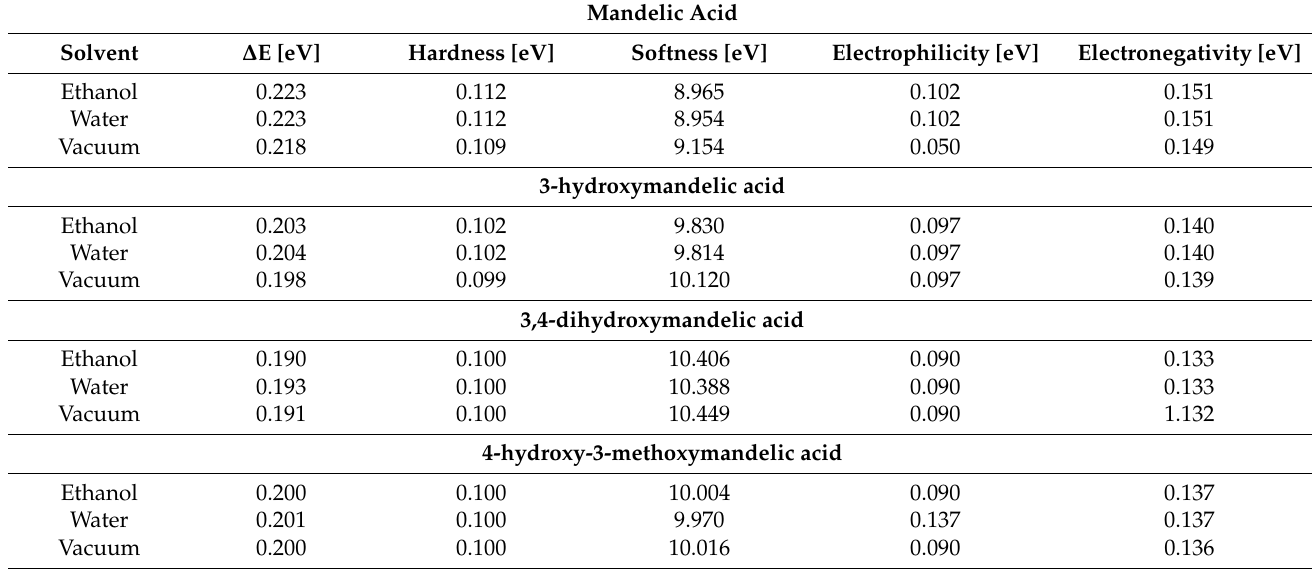
Table 4. Values of electronic parameters of studied ligands at the B3LYP/6-311 ++ G (d,p) level. Mandelic